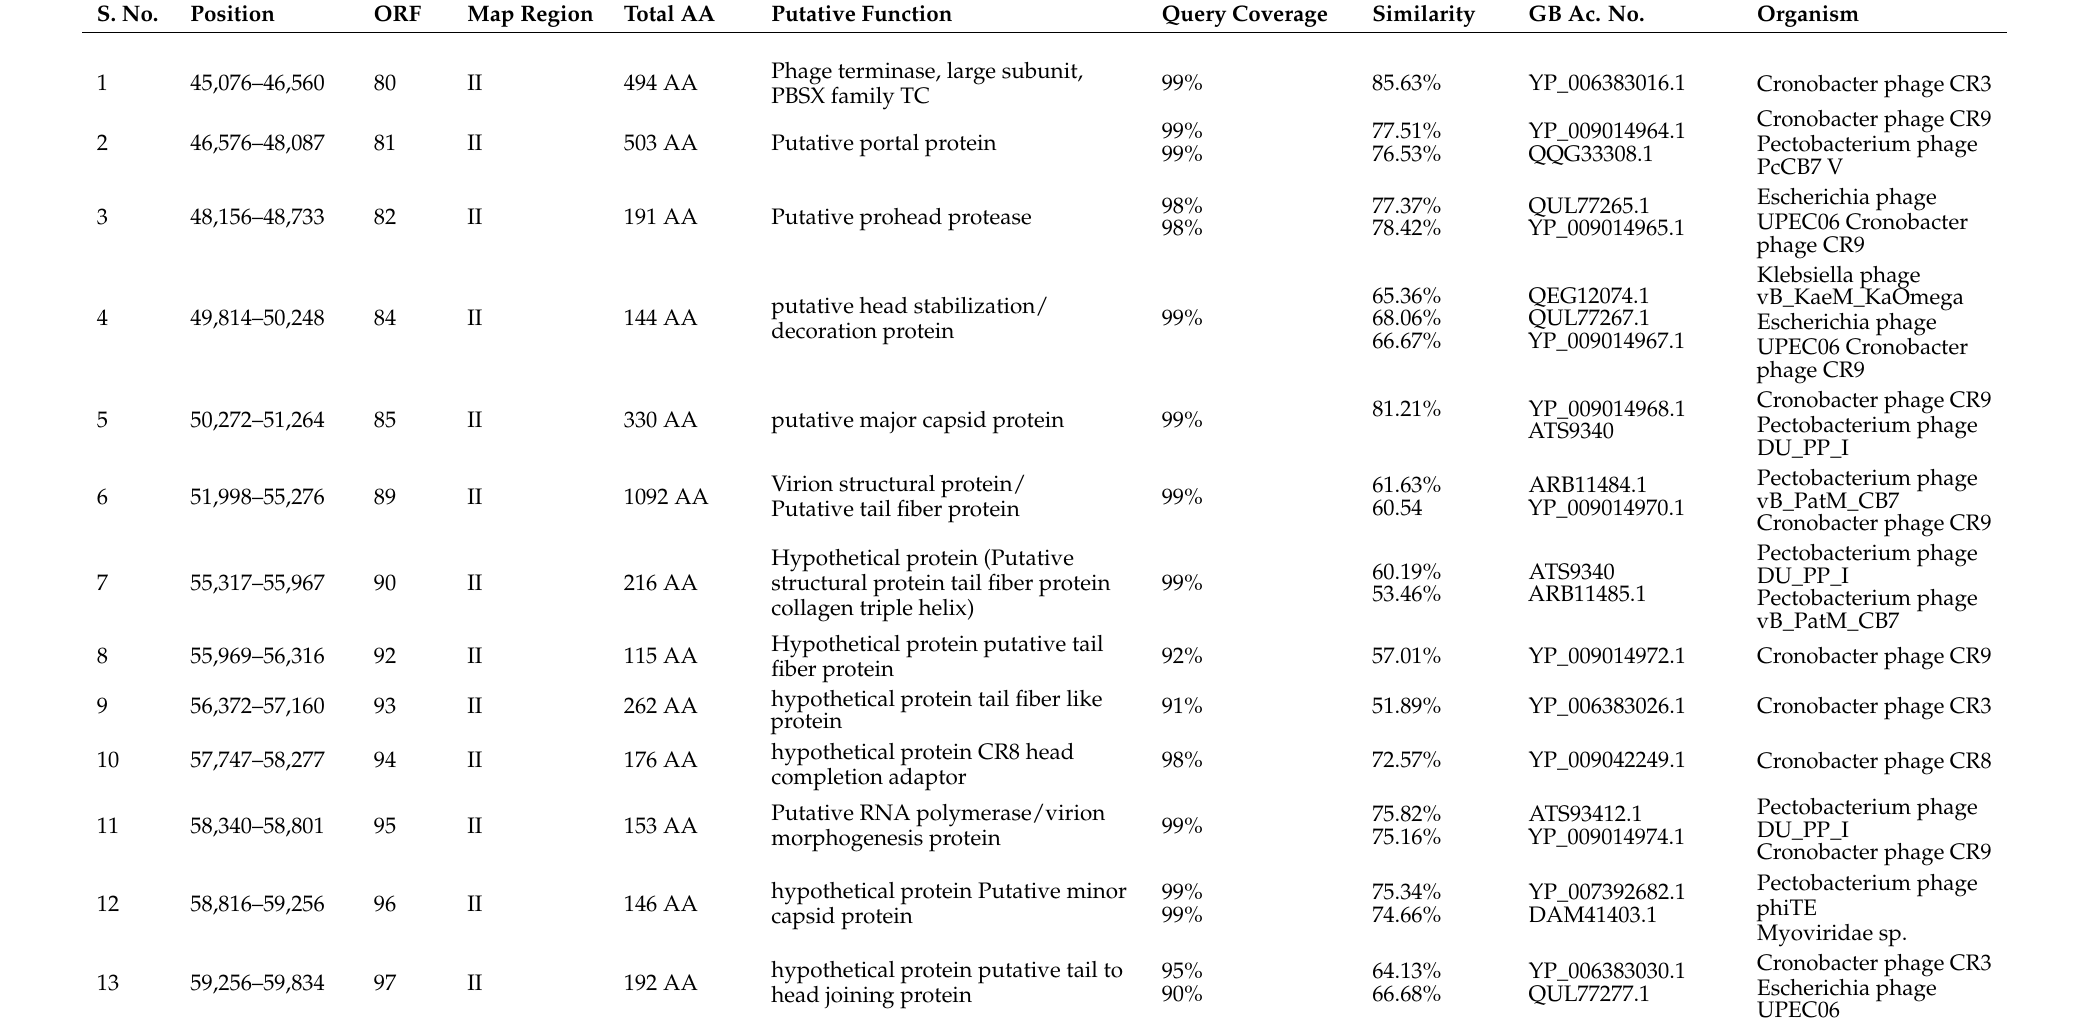
Table 1. SSBI34 putative structural protein ORFs having BLASTp homology with various members of the subfamily Vequintavirinae